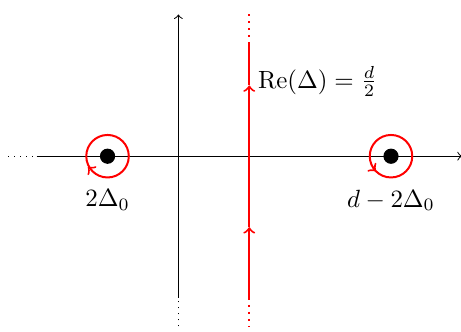
to include 2 for J